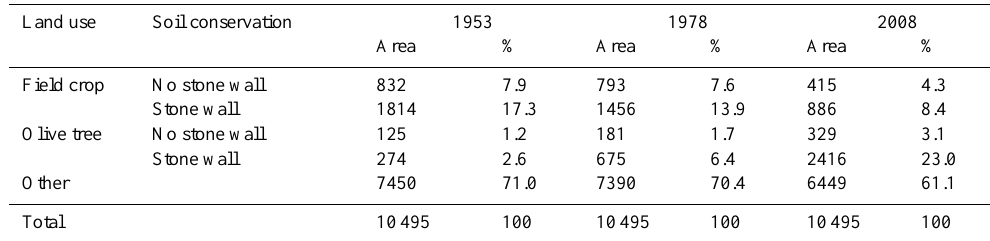
Table 3. Cultivated area covered with stone walls (ha). Land